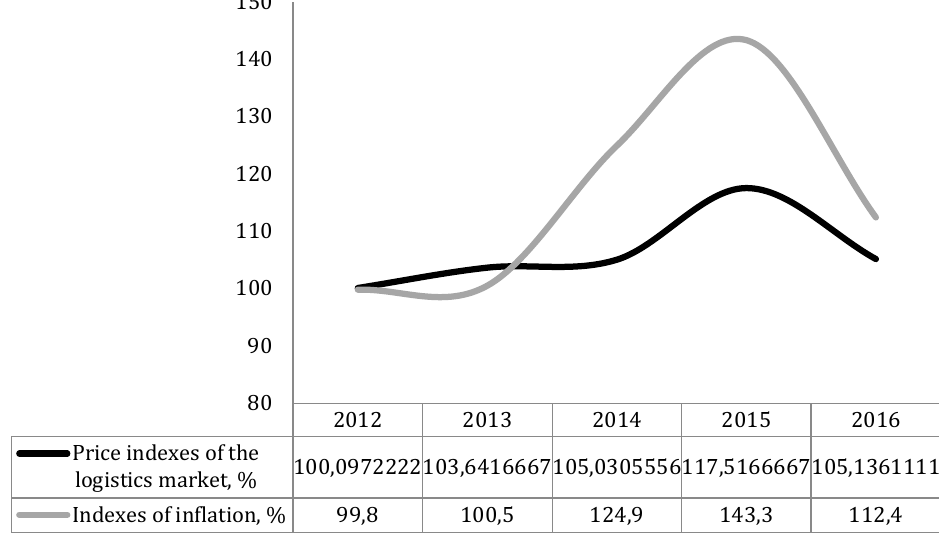
Figure 2: Dynamics of price indices of the logistics market and